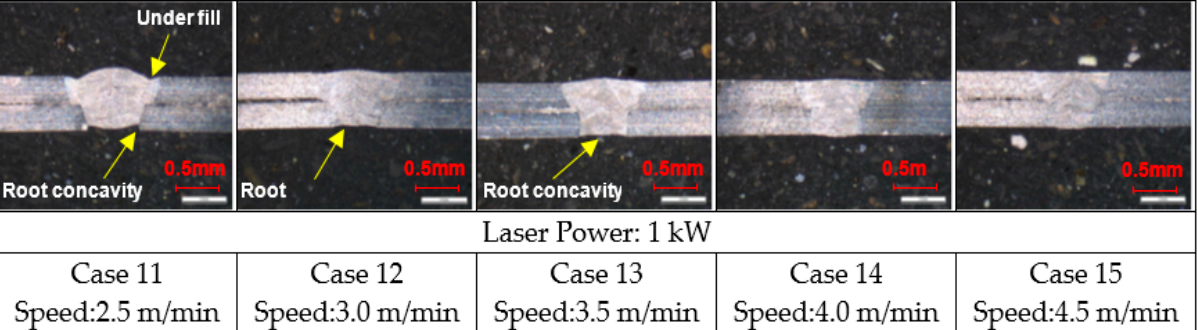
Figure 12. Bead geometry of Lap joint welding.